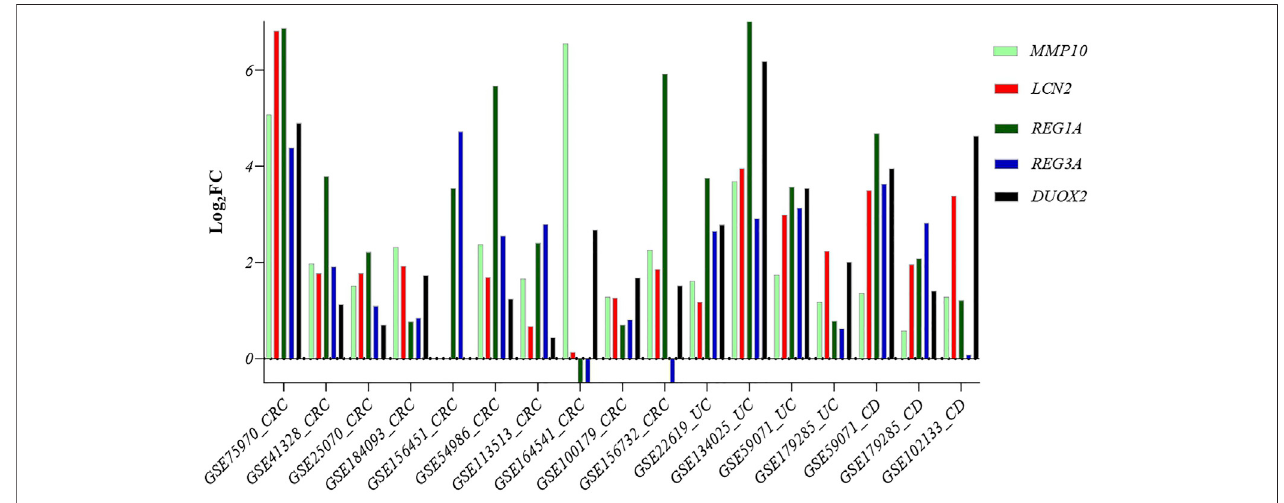
FIGURE7| Comparisonoftheexpressionlevelofthe fi vecommongenesinsamplesfromdifferentdiseases:Crohn ’ sdisease,ulcerativecolitis,andCRCpatients. Abbreviations: CRC: Colorectal cancer, UC: Ulcerative colitis, CD: Crohn ’ s